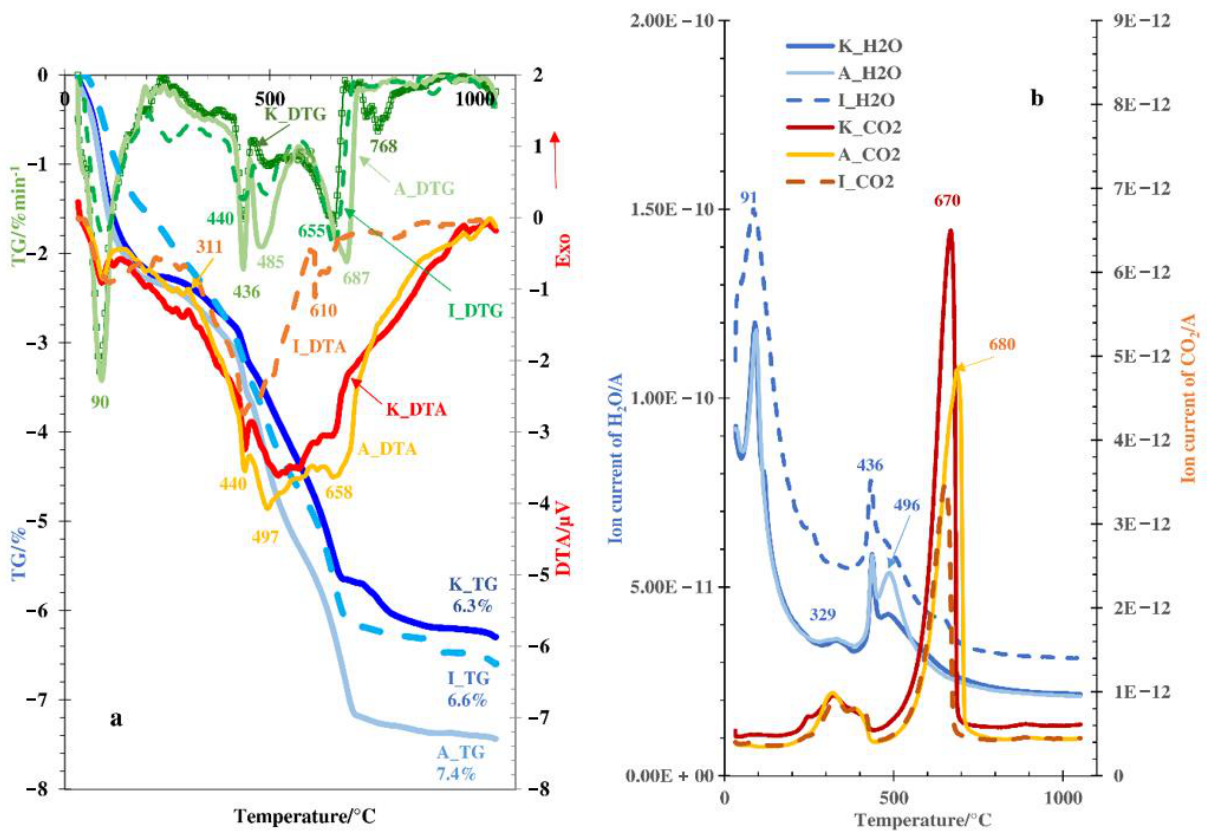
Figure 13. Thermoanalytical curves ( a ) and emission profiles of gaseous compounds ( b ) evolved at thermal treatment of blends containing 60% clay + 20% fired clay + 20% ESPA: Kunda (K), Arumetsa (A), illitic clay